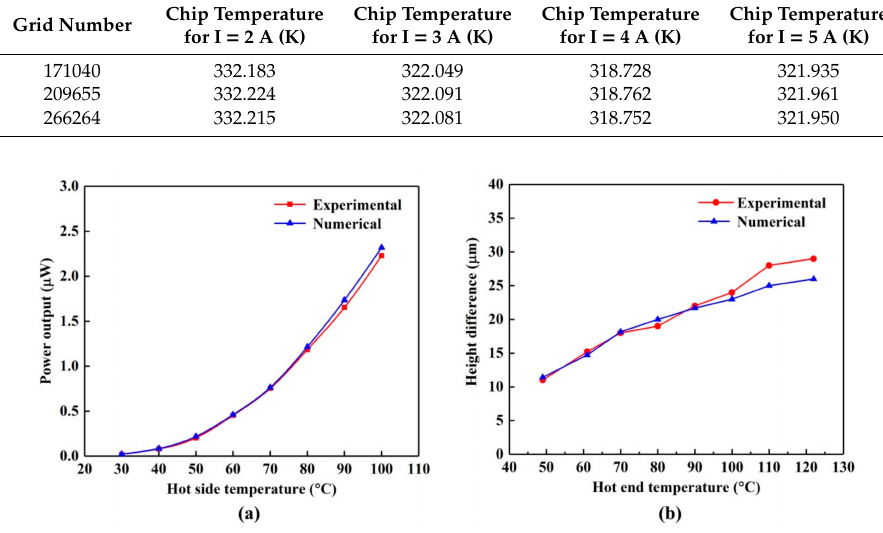
Figure 4. Comparison of simulation results and experimental results ( a ) performance validation and ( b ) thermal stress